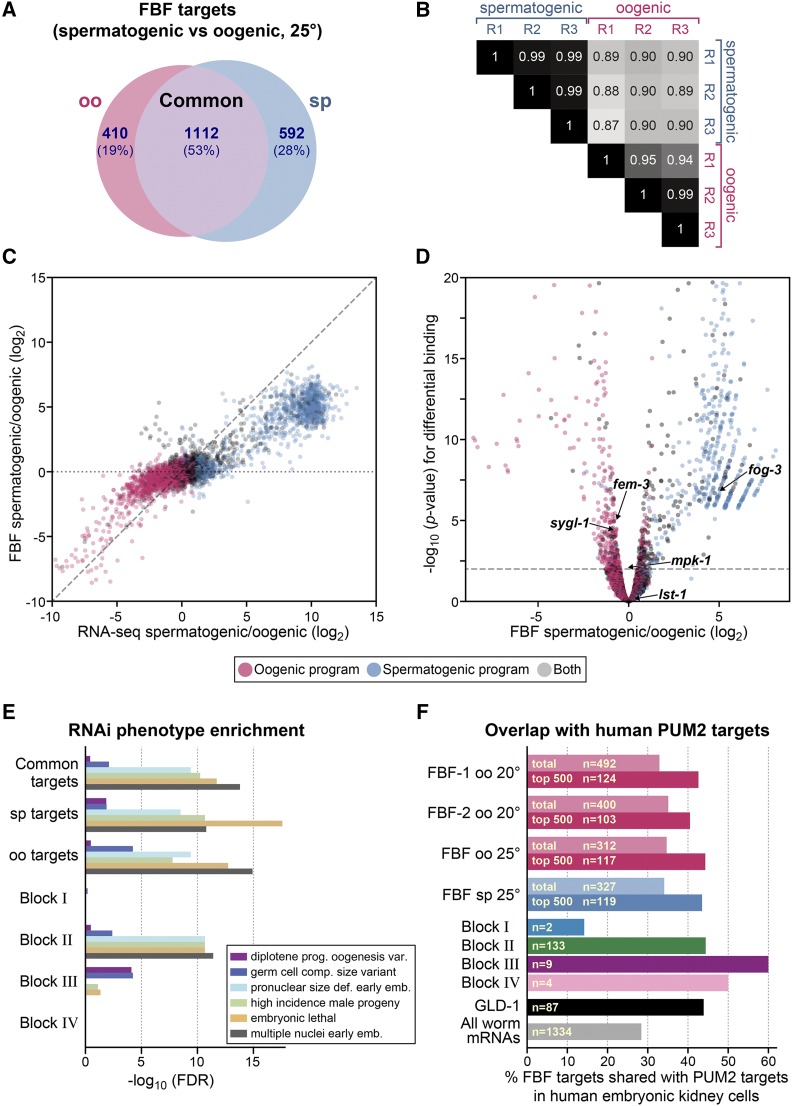
Comparisons of FBF target RNAs in spermatogenic and oogenic germlines. (A) Comparison of FBF targets in spermatogenic (blue) and oogenic animals (pink), both raised at 25°. The 1,112 common, 592 spermatogenic and 410 oogenic represent a first glimpse of potential FBF subnetworks. (B) Spearman correlations between iCLIP replicates (R) reinforce the conclusion that FBF has distinct binding landscapes in spermatogenic and oogenic germlines. Numbers represent rho values for the Spearman correlation between replicates. The oogenic FBF replicate R1 was of lower complexity than the others, which likely explains its lower correlations. (C) Spermatogenic/oogenic ratios of FBF binding (y-axis) to spermatogenic/oogenic ratios of RNA abundance (x-axis). Each dot represents an RNA: pink dots, oocyte-specific RNAs, blue dots, spermatogenic specific RNAs, and gray dots, RNA present in both genders, with germline gender-specificity assigned according to Noble et al. (2016). Dots represent all RNAs with at least one read in any of our datasets, and present in the spermatogenic or oogenic RNA program (Noble et al. 2016). Diagonal dashed line, a perfect correlation with slope 1; horizontal dotted line, no correlation. (D) Differences in FBF binding between spermatogenic and oogenic germlines. Color coding of pink, blue and gray is same as in panel (C). 12% of RNAs change binding-frequency significantly (p < 0.01, twofold) between genders, most of which are enriched in spermatogenic germlines (right arm of volcano plot has more dots than left arm). For ease of viewing, this plot cuts out the few RNAs with extreme p-values, which extend to 10−89 for spermatogenesis-enriched FBF targets and to 10−94 for oogenesis-enriched FBF targets. (E) Enrichment of RNAi phenotypes in indicated groups of RNAs, as measured by significance (Fisher’s exact test). From the WormBase database, the RNAi phenotype labels are described as follows: Diplotene progression during oogenesis variant = developing oocytes are defective during the diplotene stage of meiosis; Germ cell compartment size variant = change in germ cell compartment size; Pronuclear size defective early emb = size change in pronucleus within gametes or early zygote; High incidence male progeny = Higher frequency of male progeny than wild-type; Embryonic lethal = progeny die as embryos; Multiple nuclei early emb = inviable embryos with more than one nucleus per cell. (F) Overlaps of FBF iCLIP targets with human PUM2 PAR-CLIP targets from human embryonic kidney cells (Hafner et al. 2010). The number of ortholog groups comprising the overlap is indicated as “n=”. See text and Methods for further explanation. For comparison, the overlap with targets of the germline cell fate regulator GLD-1 (Jungkamp et al. 2011) are also given.